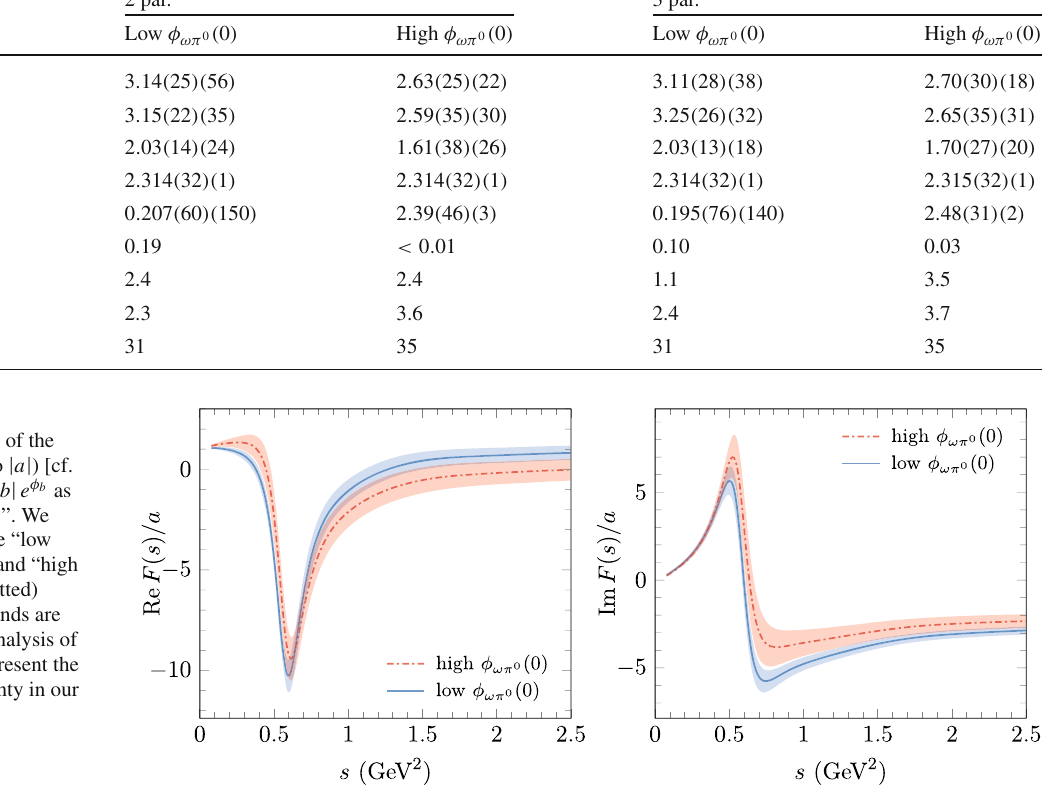
Table 2 Values of the fitted parameters (upper part) and of the different in the text and in the Appendix A. The second error is the systematic χ 2 functions (lower part) for the four different fits considered in this uncertainty attached to our calculation. It is obtained by considering a work (see Sect. 3.2 for details). The first error represents our 1 σ statisti- finite cutoff in the integral Eq. (2.28), as explained in the text cal uncertainty, and is computed through MC resampling, as explained 2 par. 3 par.